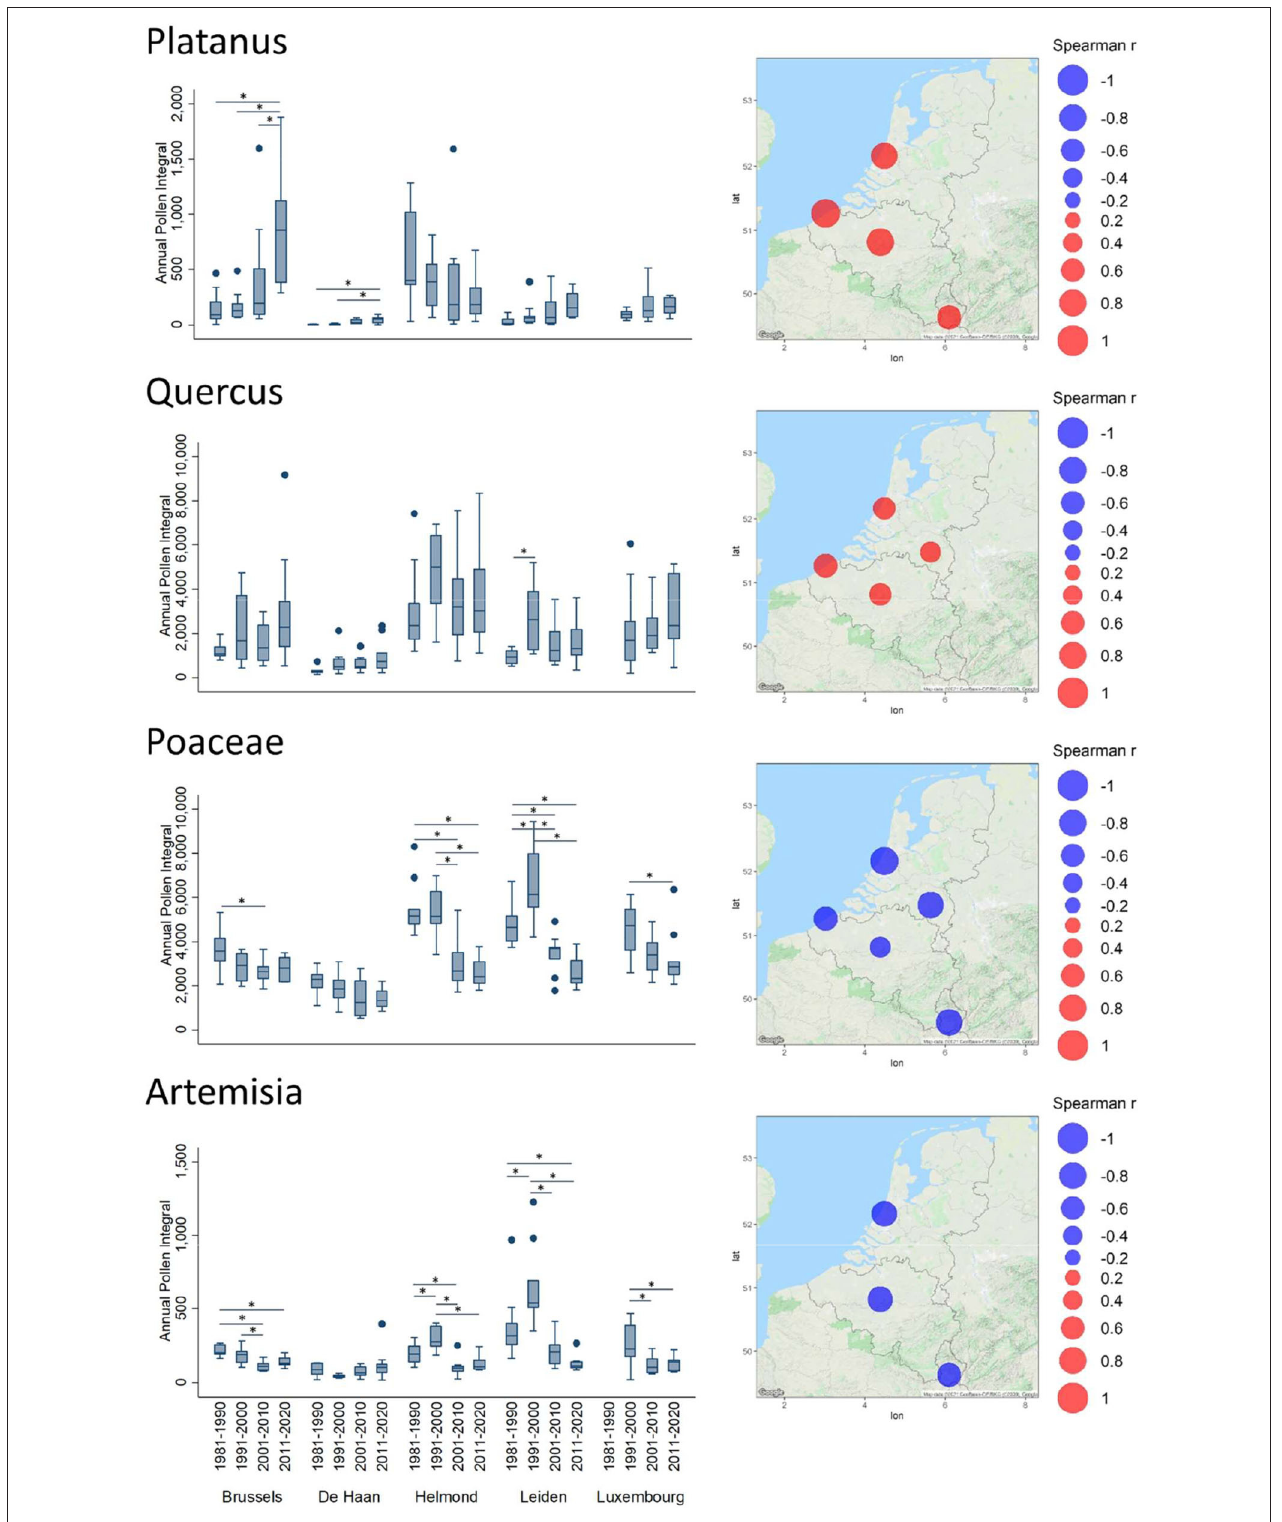
FIGURE 3 | Trends of Annual Pollen Integrals (API) for Platanus, Quercus , Poaceae, and Artemisia . For further details see, legend of Figure 2 .